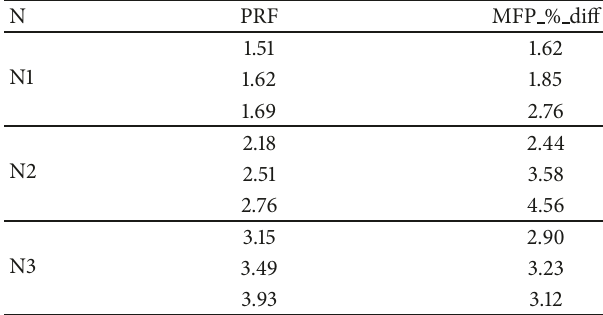
Figure 9: MFP (referred to maximum value) vs PRF in partial hub admission, CFD (blue) and experimental data (green). Table 7: Percentage difference for MFP